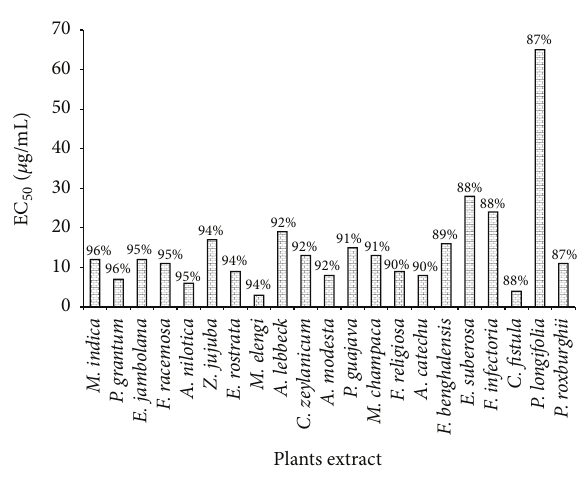
Figure 1: EC 50 values of the selected medicinal plant